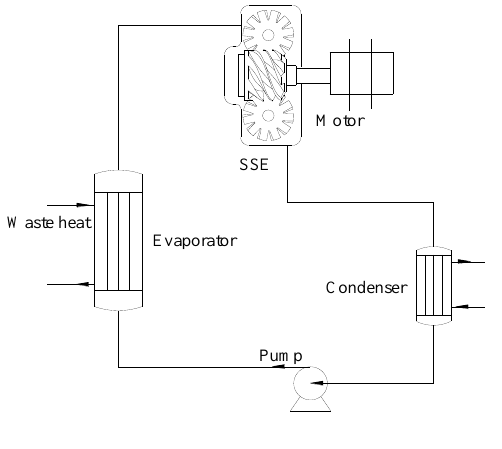
Figure 10. ORC system diagram.